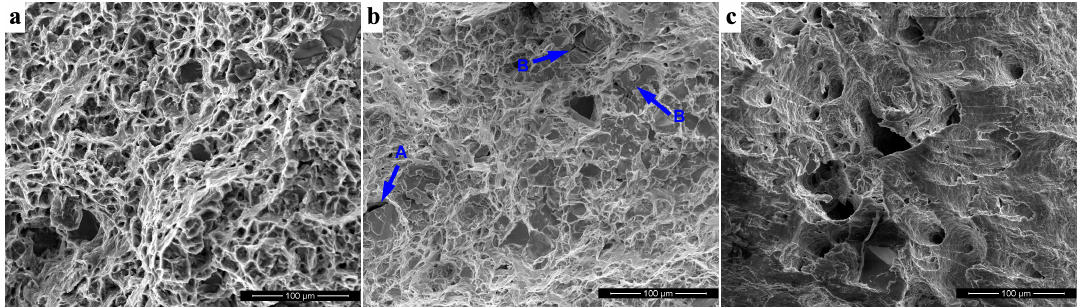
Figure 7. Fracture surface of the thixoforged composite tensile tested at 200 °C under different initial strain rates: ( a ) 0.01 s − 1 ; ( b ) 0.15 s − 1 ; ( c ) 0.2 s − 1 .